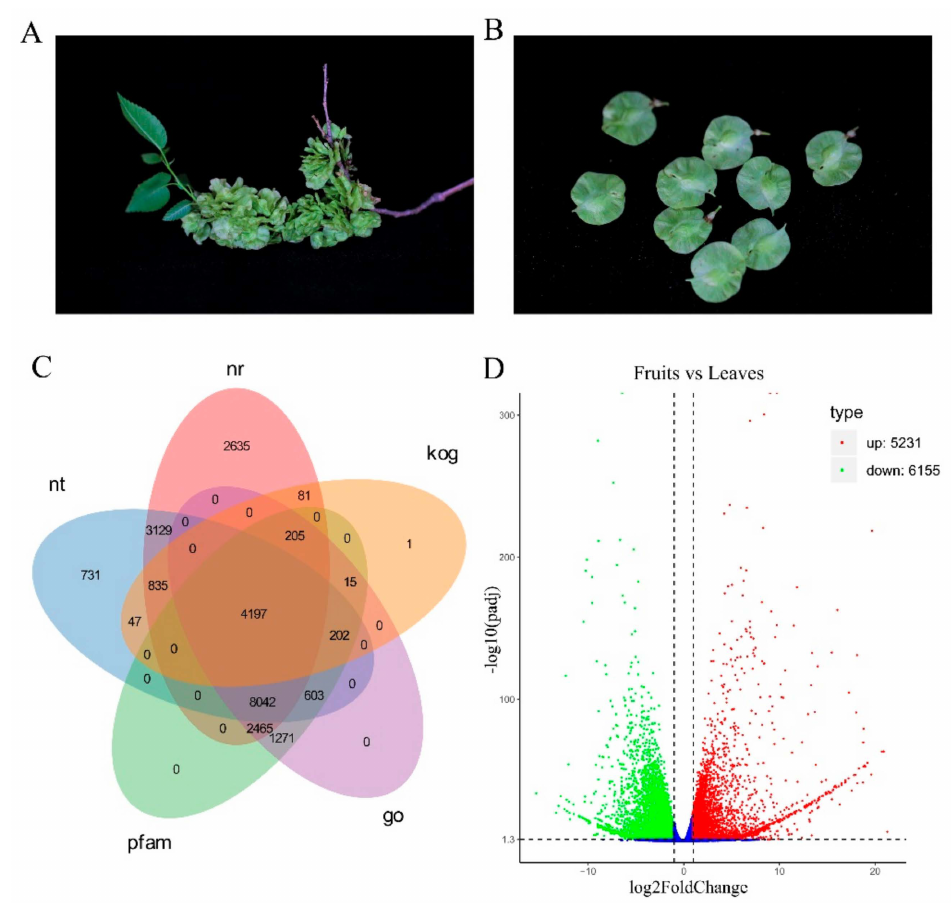
Figure 1. ( A ) The morphology of elm ( Ulmus pumila ) fruits and leaves. ( B ) The morphology of U. pumila fruits. ( C ) Venn diagram of functional annotations of unigenes in nt (NCBI nonredundant protein sequences), nr (NCBI nonredundant protein sequences), kog (Clusters of Orthologous Groups of proteins), go (Gene Ontology), and pfam (Protein family) databases. ( D ) Expression patterns of di ff erentially expressed genes (DEGs) identified between fruits and leaves. Red and green dots represent DEGs, grey dots indicate genes that were not di ff erentially expressed. In total, 11,386 unigenes were revealed to be di ff erentially expressed (padj < 0.05) in fruit compared with control samples, with 5231 being upregulated and 6155